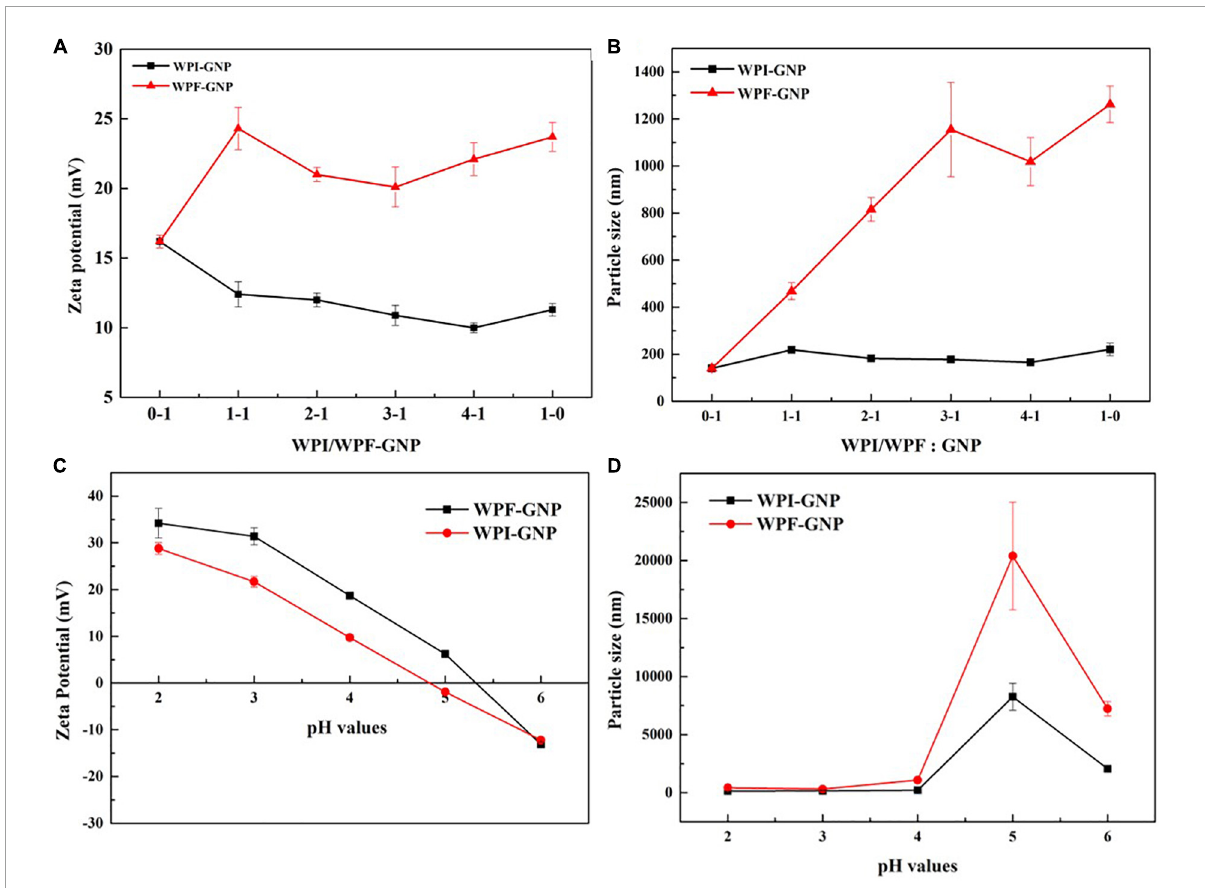
FIGURE3 (A,B) Zeta potential and particle size distribution of WPI-GNP hybrids, WPF-GNP hydrogel at various ratio (pH 4.0); (C,D) Zeta potential and particle size distribution of WPI-GNP hybrids, WPF-GNP hydrogel at ratio of 4:1 with pH values ranging from 2.0 to